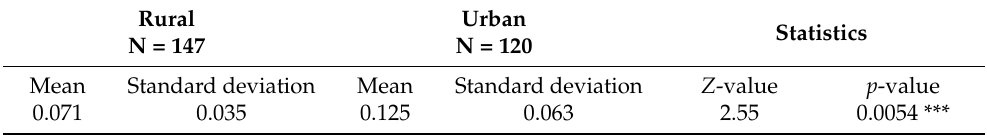
Table 4. Variation in household food waste proportion between rural and urban